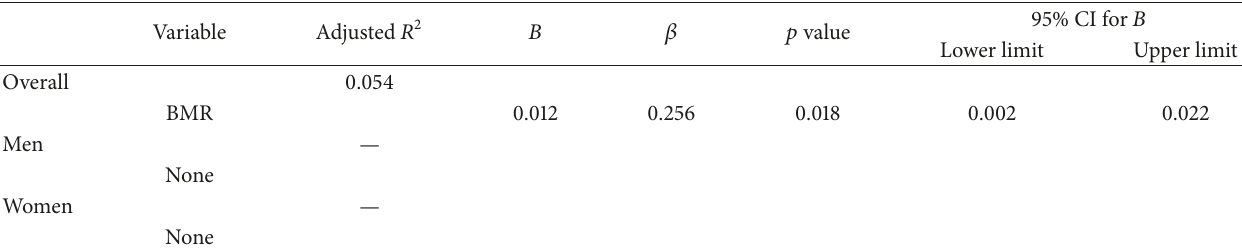
Table 2: Results of multiple regression analysis with PPT as a dependent